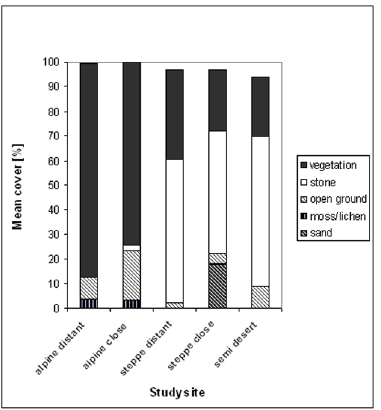
Figure 3. Mean cover of vegetation and particle size of the ground at study sites of alpine region, mountain steppe and semi-desert.